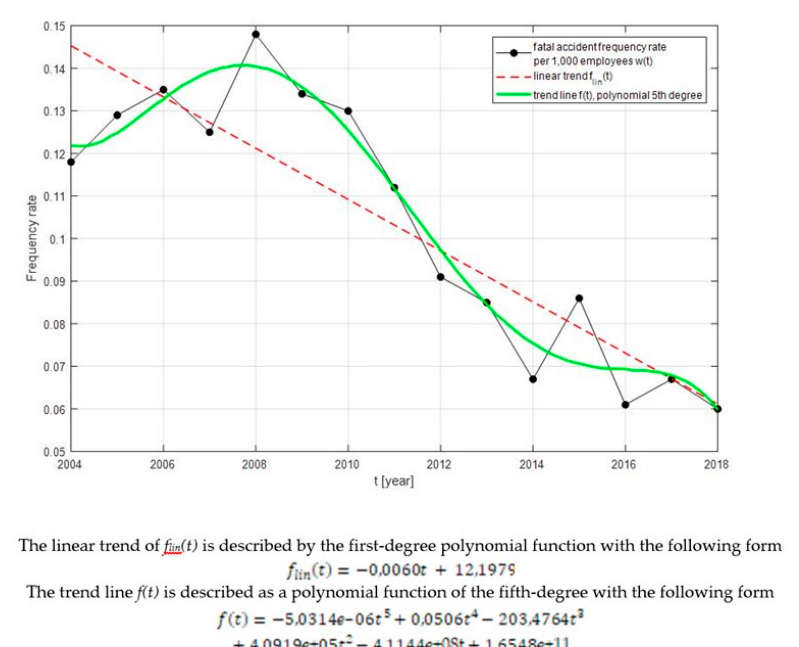
Figure 5. Trends of changes in the ratio of the index of the indicator of frequency of total accidents in civil engineering.